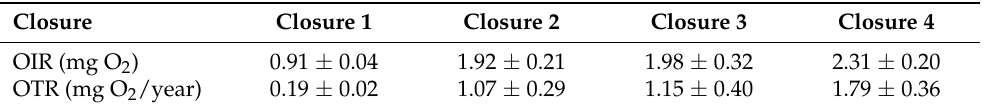
Table 2. Types and permeability parameters for the four micro agglomerated cork closures (OIR: oxygen initial rate; OTR: oxygen transfer